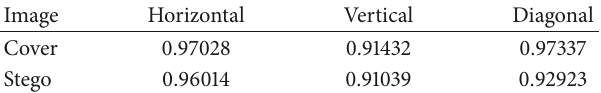
Table 5: The correlation